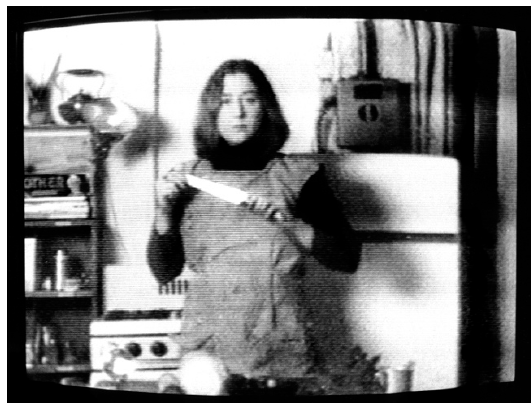
Figure 7. Martha Rosler, Semiotics of the Kitchen , 1975, video, Video Data Bank, USA.